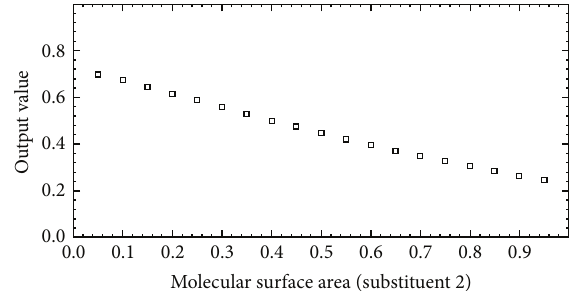
Figure 8: Dependency graph illustrating the correlation between the molecular surface area (substituent 2) used to train the neural network architecture versus the actual activity data.